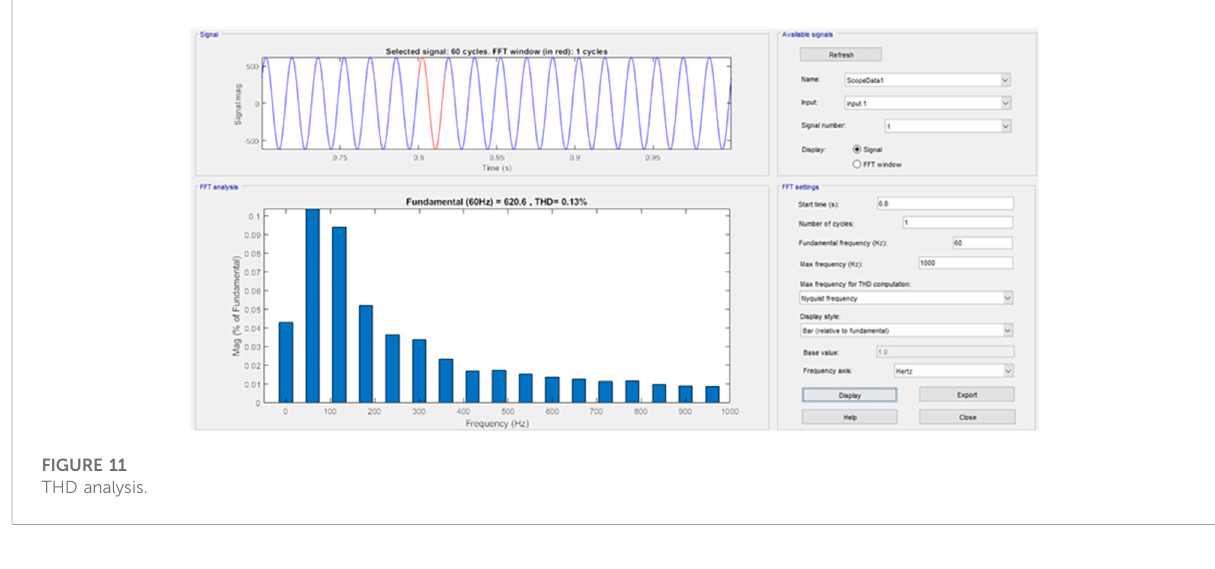
FIGURE 11 THD analysis.